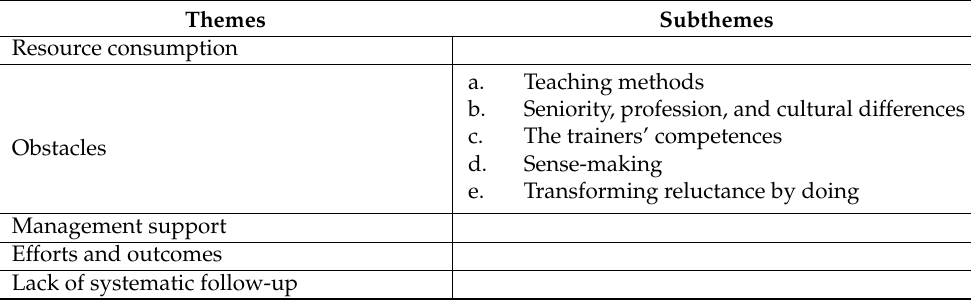
Table 2. Themes and subthemes derived from the thematic